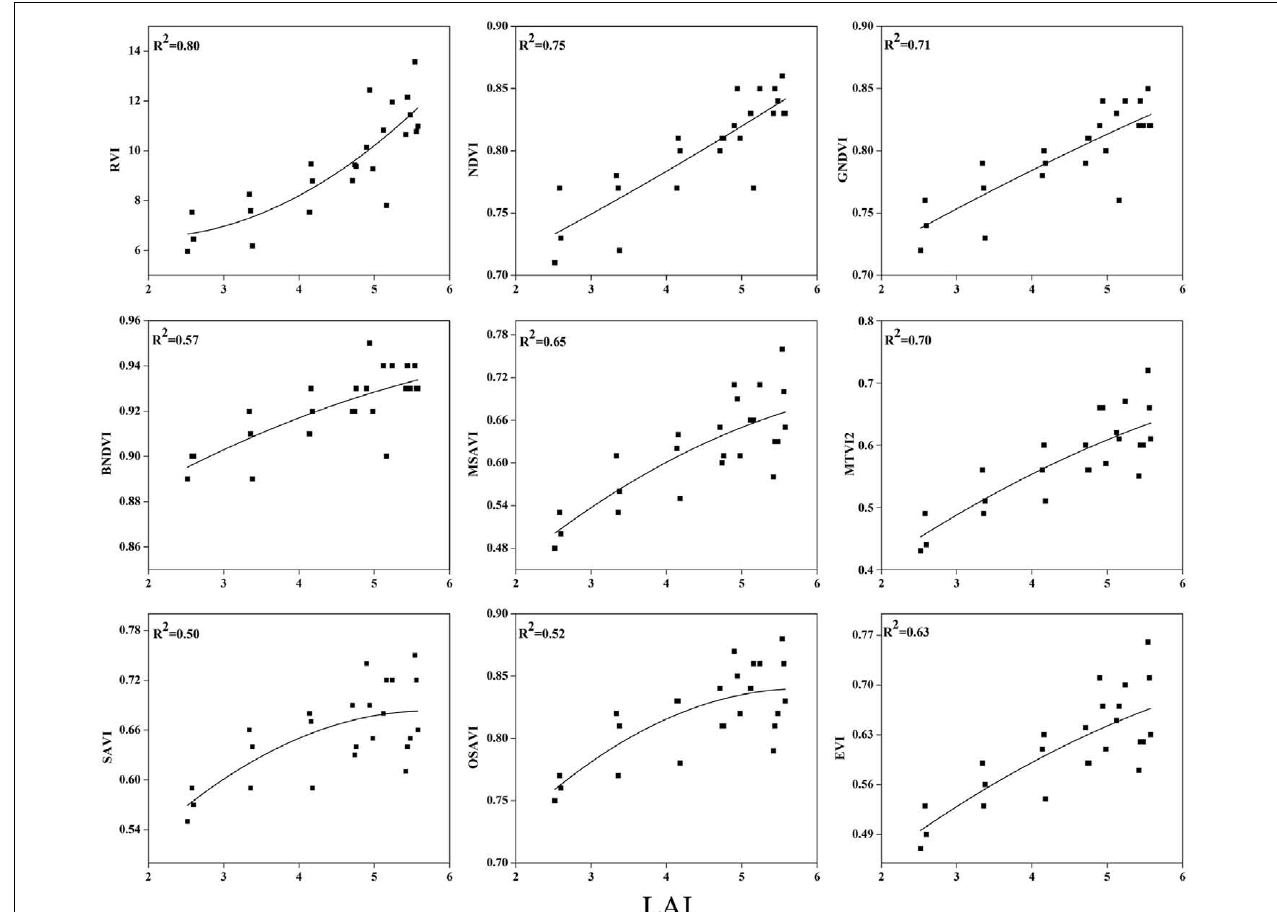
FIGURE 9 | Best-fit models between VIs and LAI at heading stage.